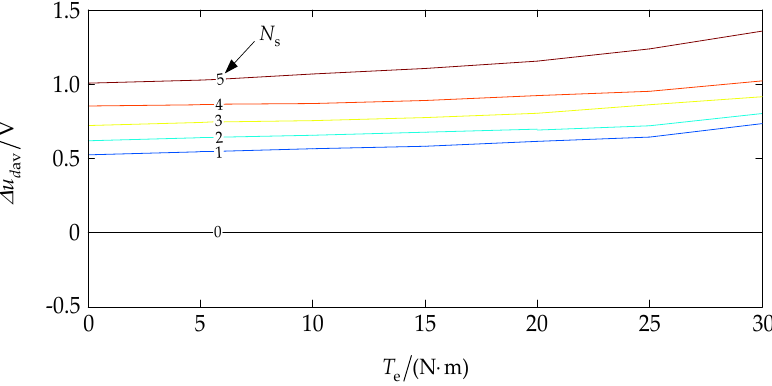
Δ u with the number of short-circuited turns and the